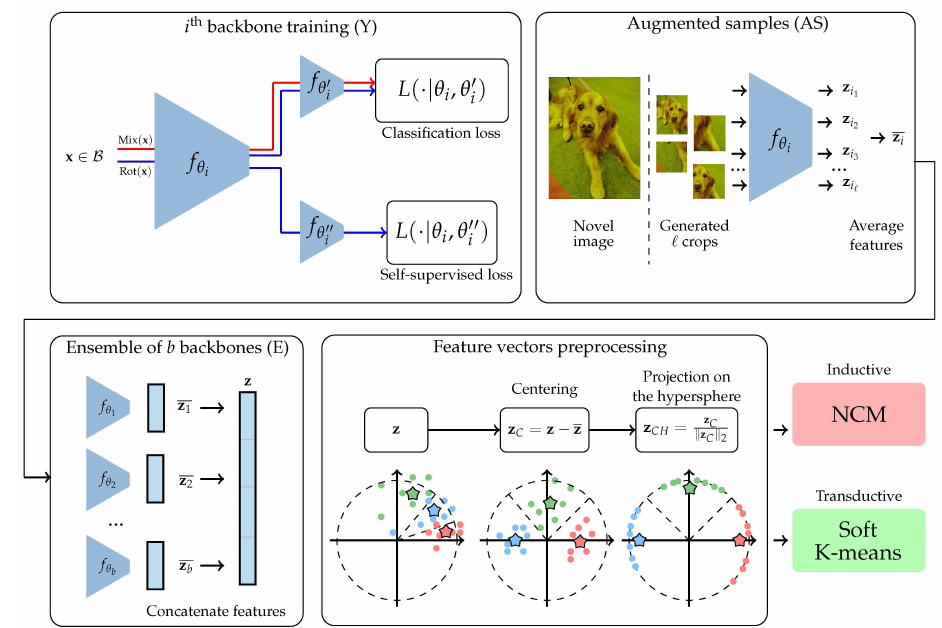
Figure 1. Illustration of our proposed method. Y: We first train multiple backbones using the base and validation datasets. We use two cross-entropy losses in parallel: one for the classification of base classes and the other for the self-supervised targets (rotations). We also use manifold mixup [18]. All the backbones are trained using the exact same routine, except that their initialization is different (random) and the order in which data batches are presented is also potentially different. AS: Then, for each image in the novel dataset and each backbone, we generate multiple crops, then compute their feature vectors, which we average. E: Each image becomes represented as the concatenation of the outputs of AS for each of the trained backbones. Preprocessing: We add a few classical preprocessing steps, including centering by removing the mean of the feature vectors of the base dataset in the inductive case, or the few-shot run feature vectors for the transductive case, and projecting on the hypersphere. Finally, we use a simple nearest class mean classifier (NCM) if in the inductive setting or a soft K-means algorithm in the transductive